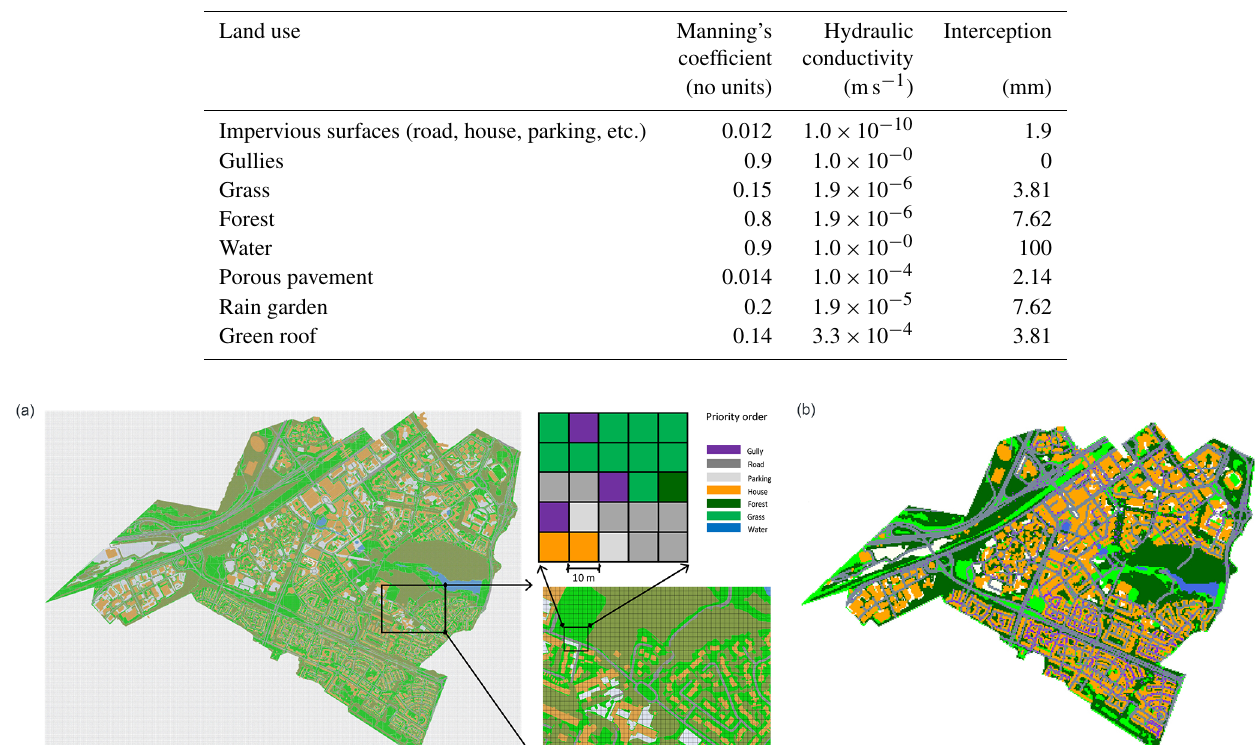
Table 2. Hydrological parameters for each land use class.